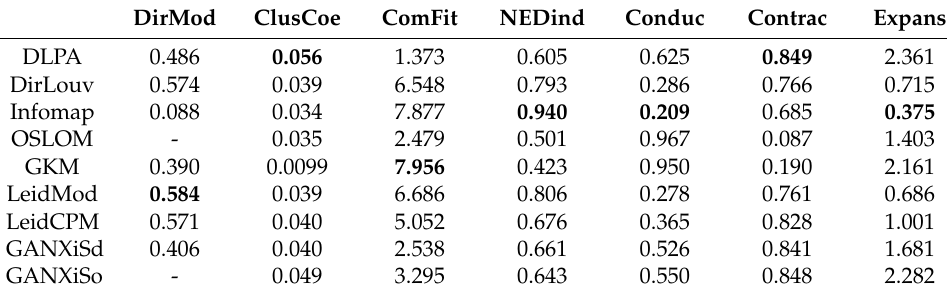
Table 1. Results of evaluations by metrics on the Biryulevo dataset.